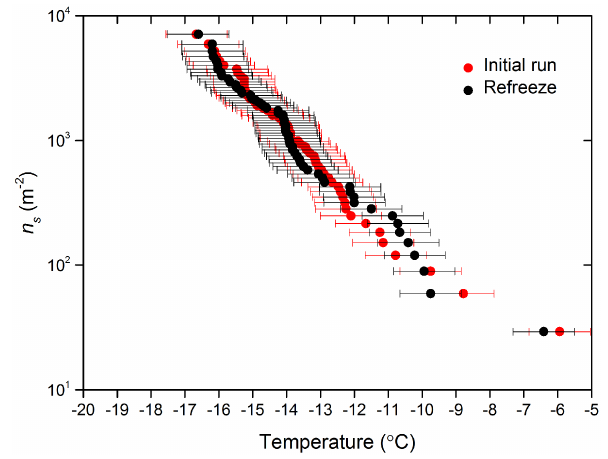
Figure 8. The active site density, n s (T ) , for a 0.01wt% NX-illite suspension and n s (T ) from a corresponding second freezing run with the same droplets after they had been thawed out and refrozen.